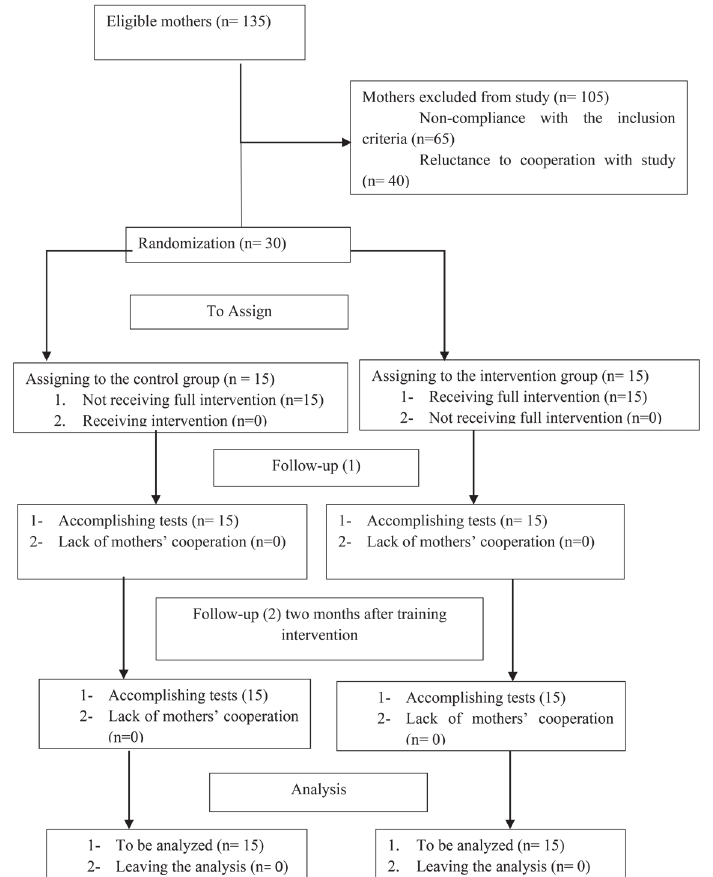
Figure 1. The flowchart of the study